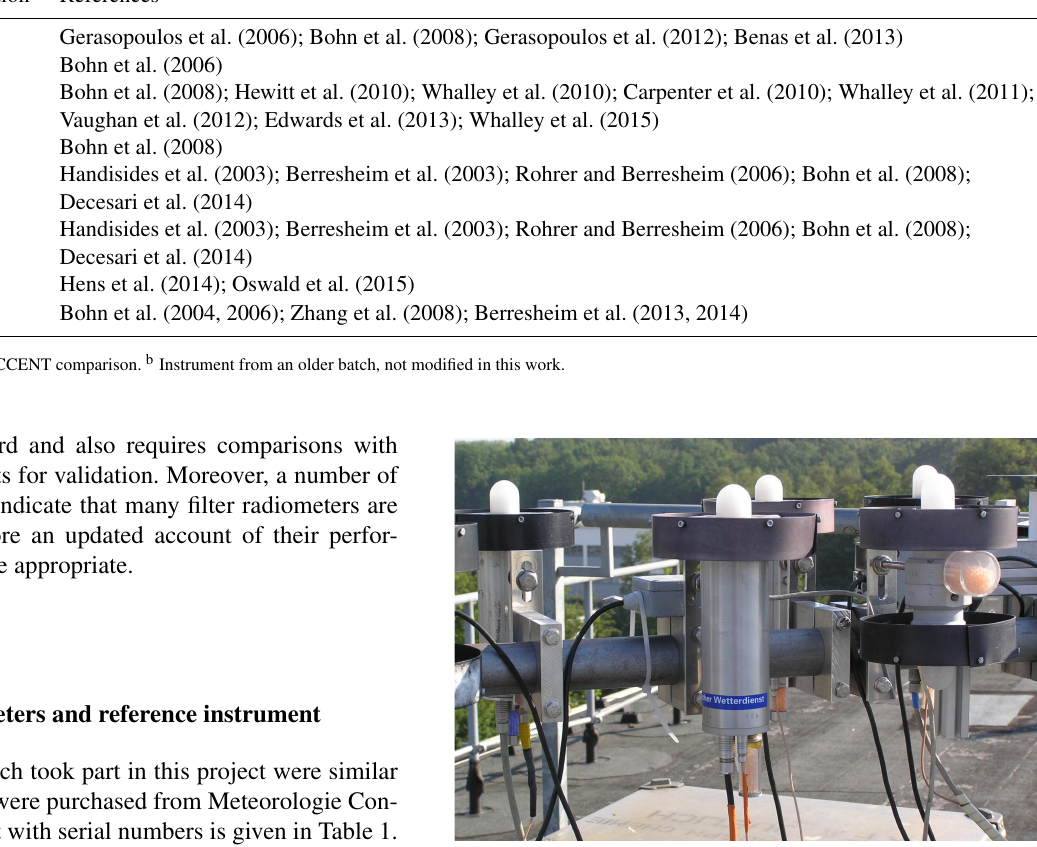
Figure 1. Impression of filter radiometers operated side by side dur- ing the ACCENT intercomparison (Bohn et al.,